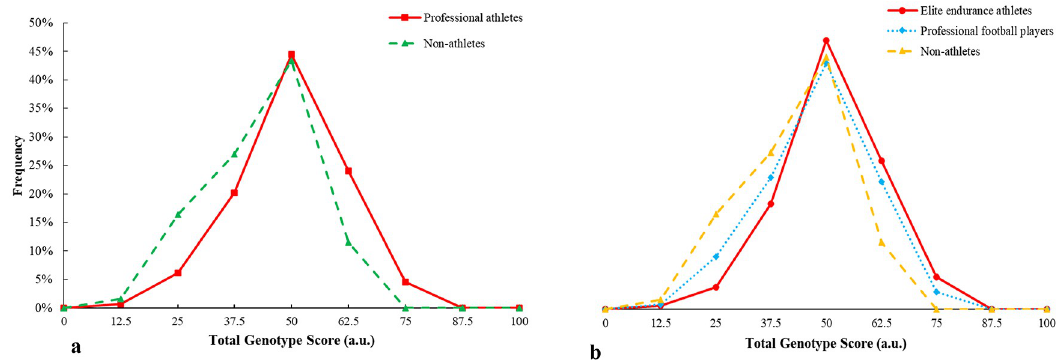
Fig 3. TGS distribution of iron metabolism and energy efficiency in a) professional athletes and non-athlete subjects and b) elite endurance athletes and professional football players with regard to non-athlete